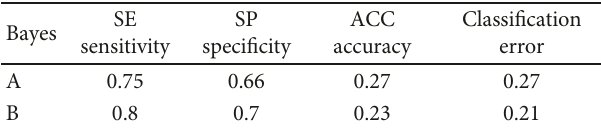
Figure 6: Position of ten outliers detected in the extended database. Table 3: Measures of rating classi fi ers for Bayes case-based reasoning for two approaches (A) and (B).